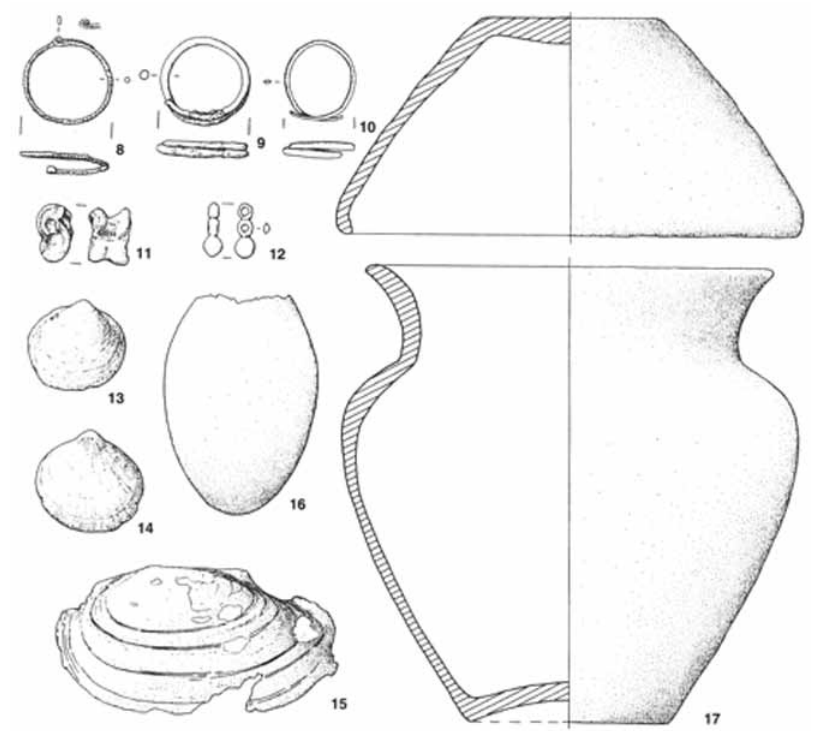
Figure 4. Grave goods from Lovara tomb 13. 8-10: bracelets; 17: urn; 11: astragalus; 12: bronze pendant; 13-15: shells; 16: swan egg (Salzani